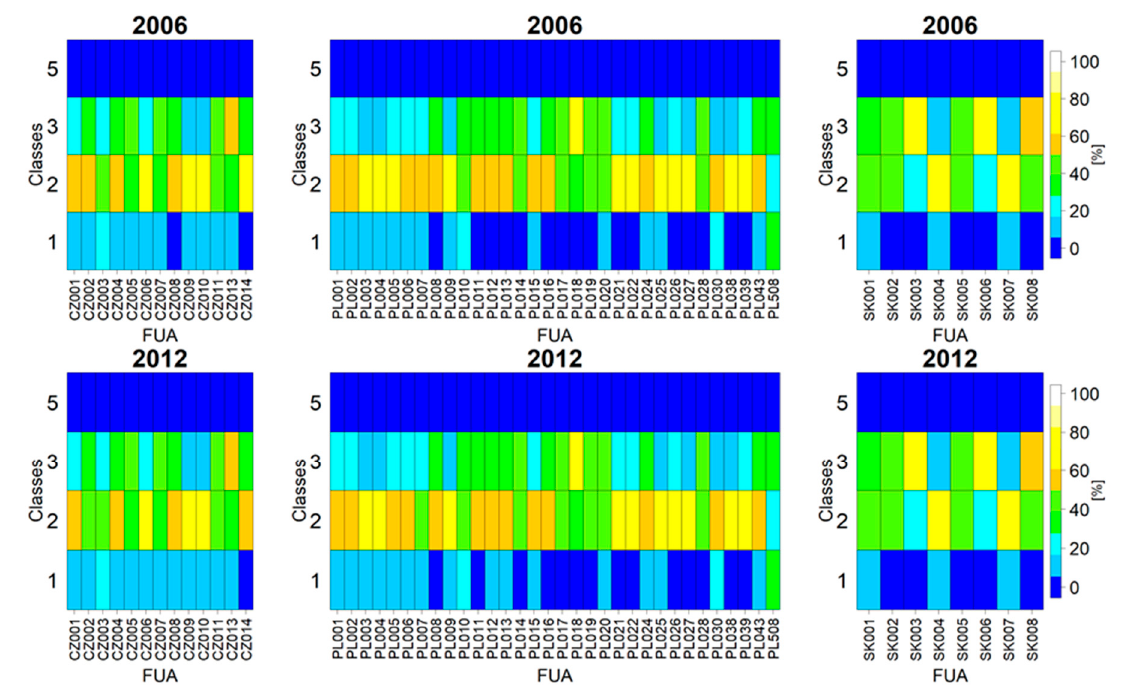
Figure 2. The shares of land- use (LU) classes 1, 2, 3, and 5 in the analysed FUAs in 2006 and